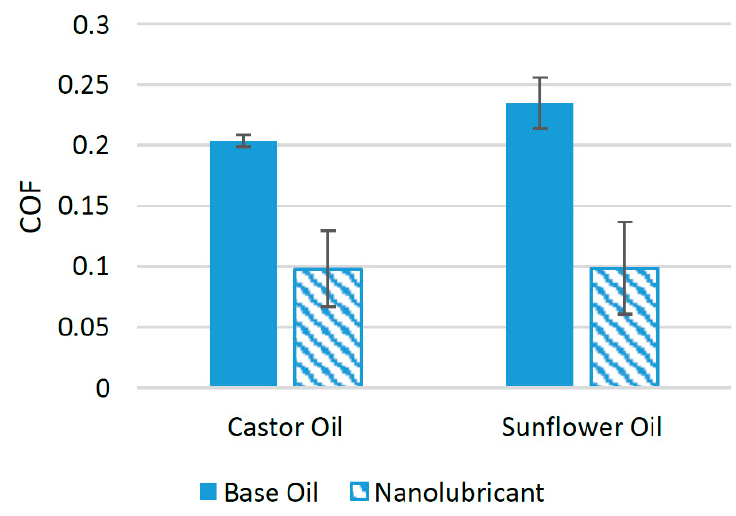
Figure 17. Effect of MoS 2 NPs on the friction performance of bio-lubricants.